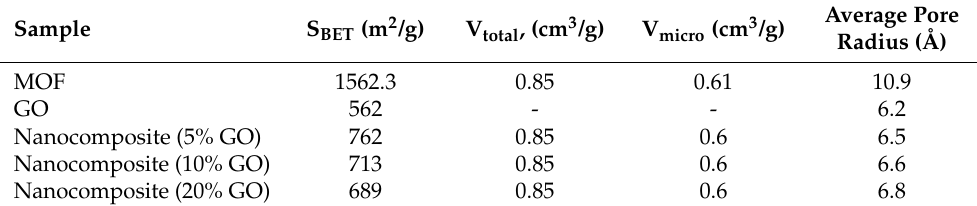
Table 2. Characteristics of MOFs, GO and nanocomposites. Sample